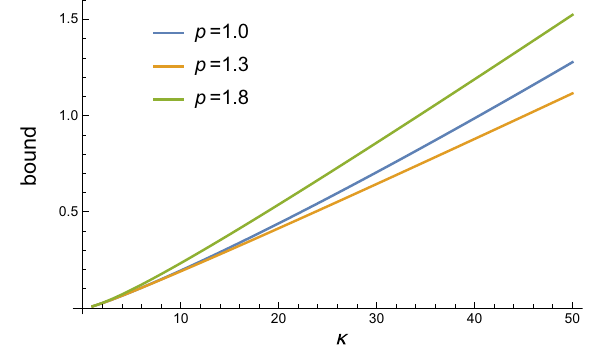
FIG. 2. The upper bound on the error in the adiabatic evolution versus the condition number κ for a range of values of p used in the scheduling function f ( s ) . The upper bound on the error is computed using Theorem 7 and in all cases the number of steps of the walk is T = 10 5